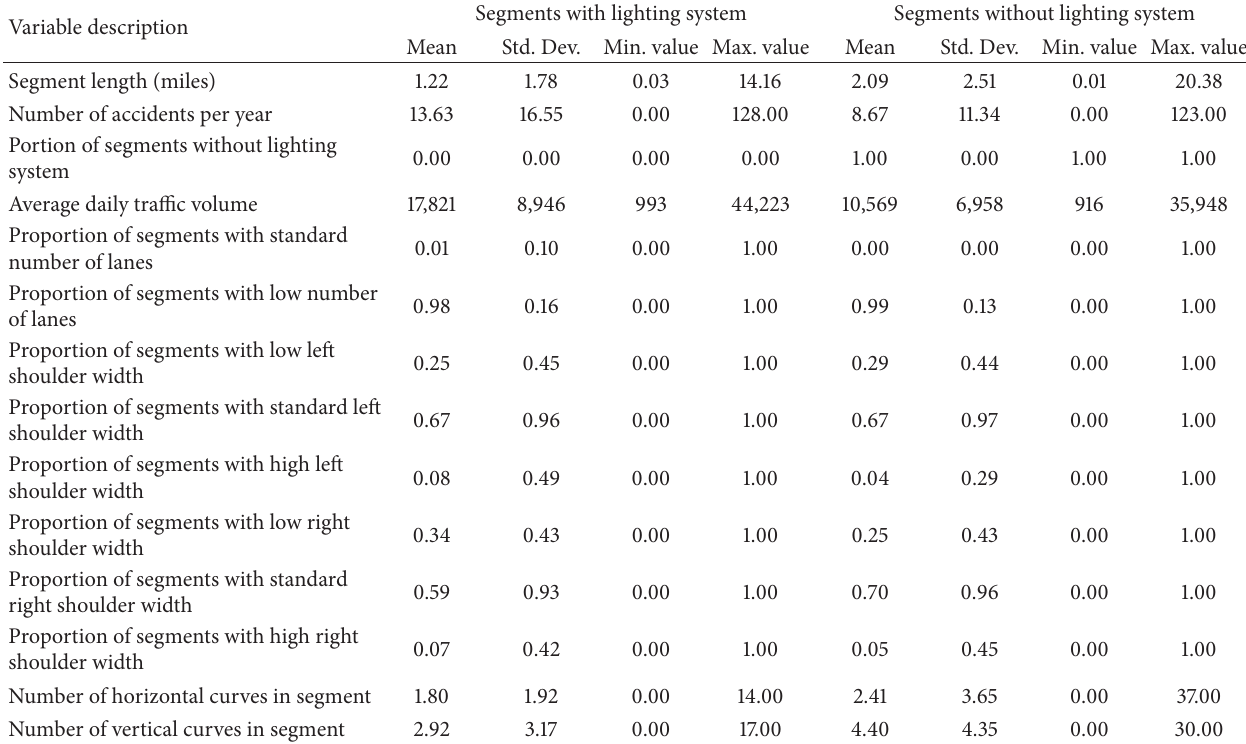
Table 1: Descriptive statistics of